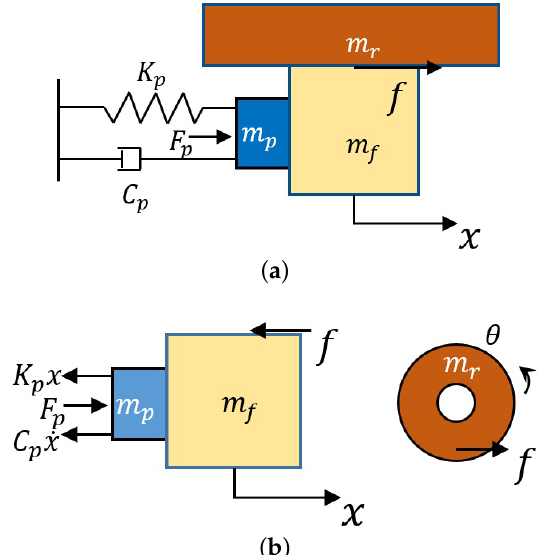
Figure 5. ( a ) Overall dynamic model of the mechanism; and ( b ) force analysis of the friction body and the PZT stack and force condition of the